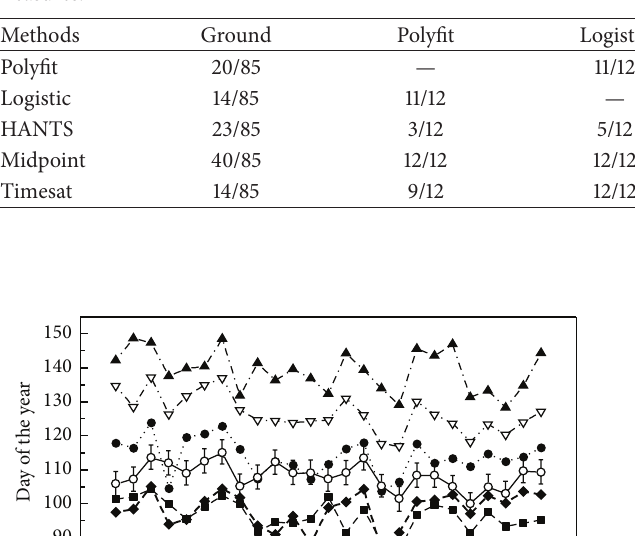
Table 4: The proportions of significant Pearson’s R (𝑃 < 0.05) between time series of ground phenophases and five satellite-derived SOS measures.